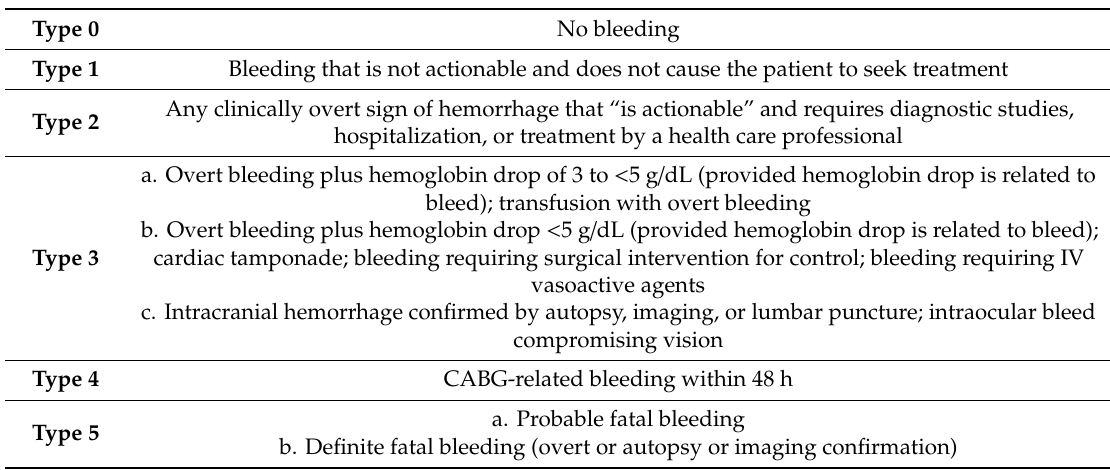
Table 1. Bleeding Academic Research Consortium definition for bleeding (modified from